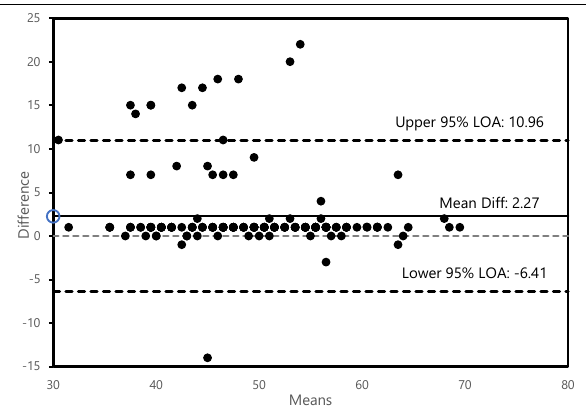
Figure 3 . Bland-Altman Plot for the SW. Positive Y-axis Values Indicate SW Push Counts that Were Less Than Manual Push Counts and Vice-versa.